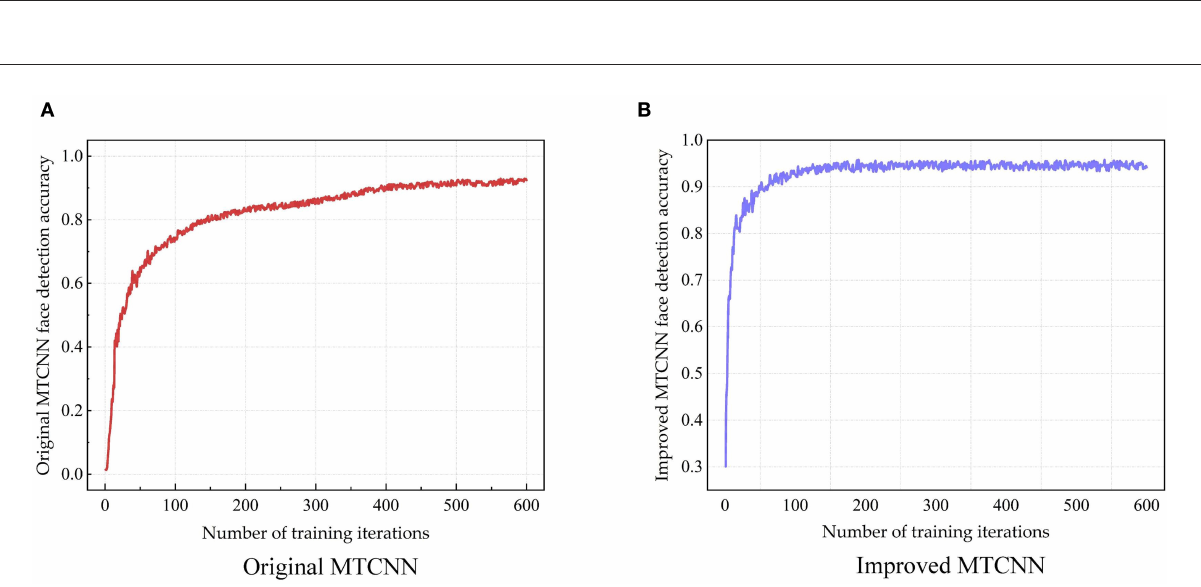
FIGURE7 The training results of MTCNN face detection model—Accuracy of original MTCNN (A) and improved MTCNN (B)